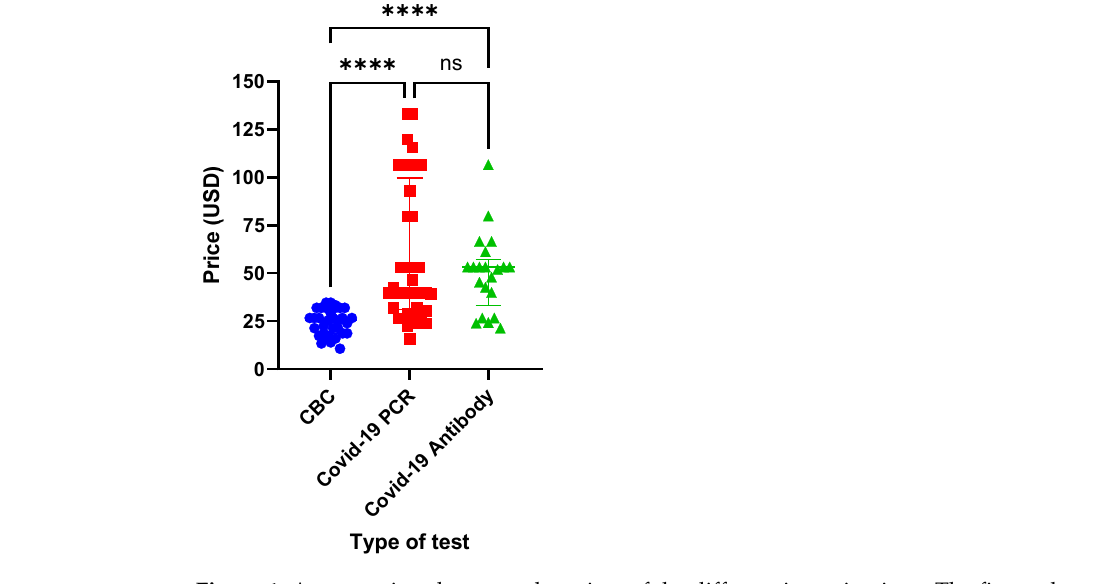
Figure 1. A comparison between the prices of the different investigations. The figure demonstrates a CBC (blue circles) to have a significantly lower price as compared to COVID-19 PCR tests (red squares) and antibody titers (green triangles). Prices are presented in USD. **** denotes a p -value of <0.0001. CBC: complete blood count; ns: non-significant; USD: United States dollars.